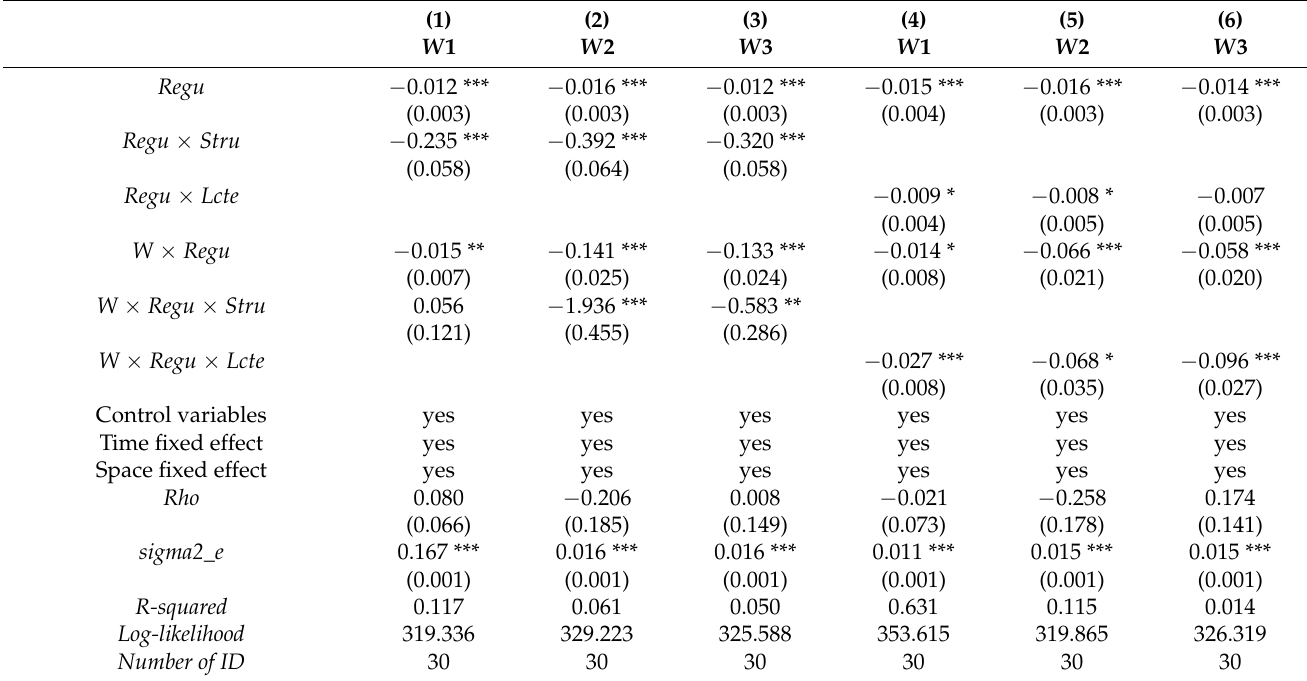
Table 16. Test of industrial structure optimization effect and low carbon technology capability improvement